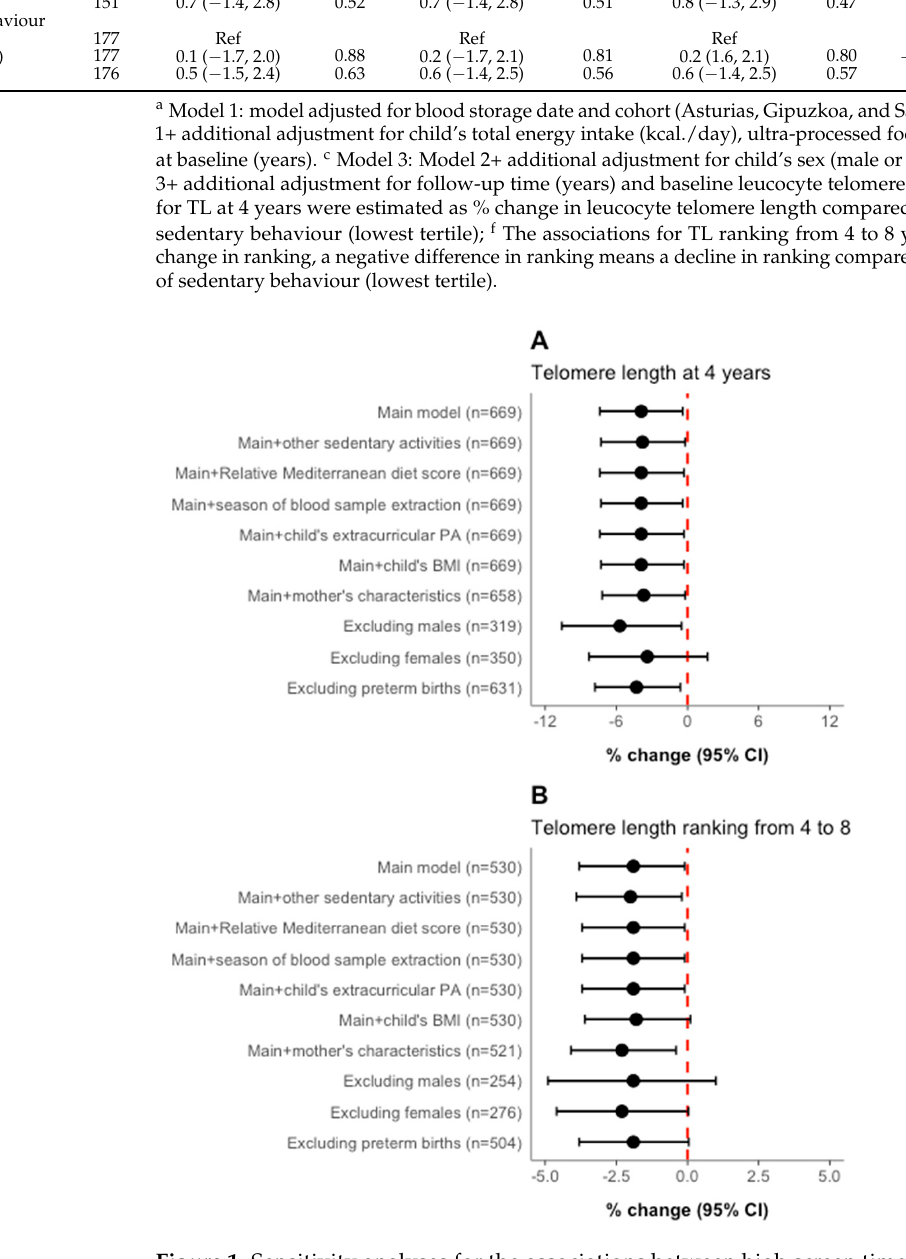
Figure 1. Sensitivity analyses for the associations between high screen time and telomere length at 4 years ( A ) and telomere length ranking from 4 to 8 years ( B ). Abbreviations: BMI, body mass index; PA, physical activity. CI, confidence interval. Adjustment variables: other sedentary activities (low, middle, and high); relative Mediterranean diet score (rMed, continuous), season of blood sample extraction (spring, summer, autumn, or winter); child’s extracurricular PA (METs-h/day) and child’s BMI (kg/m 2 ). Mother characteristics include the following: periconceptional BMI (kg/m 2 ); smoking status at baseline (yes or no), and educational level (primary, secondary, or university). ( A ): Main model adjusted for blood storage time, cohort (Asturias, Gipuzkoa, and Sabadell), child’s age (years), sex (male or female), energy intake (kcal/day), and ultra-processed food intake (g/day). The associations were estimated as % change in TL compared to the reference group (lowest tertile). ( B ): Main model adjusted for blood storage time, cohort (Asturias, Gipuzkoa, and Sabadell), child’s age (years), sex (male or female), energy intake (Kcal/day), ultra-processed food intake (g/day), follow- up time (years), and baseline leucocyte telomere length. The estimates were expressed as % change in TL ranking compared with the reference group (lowest tertile).